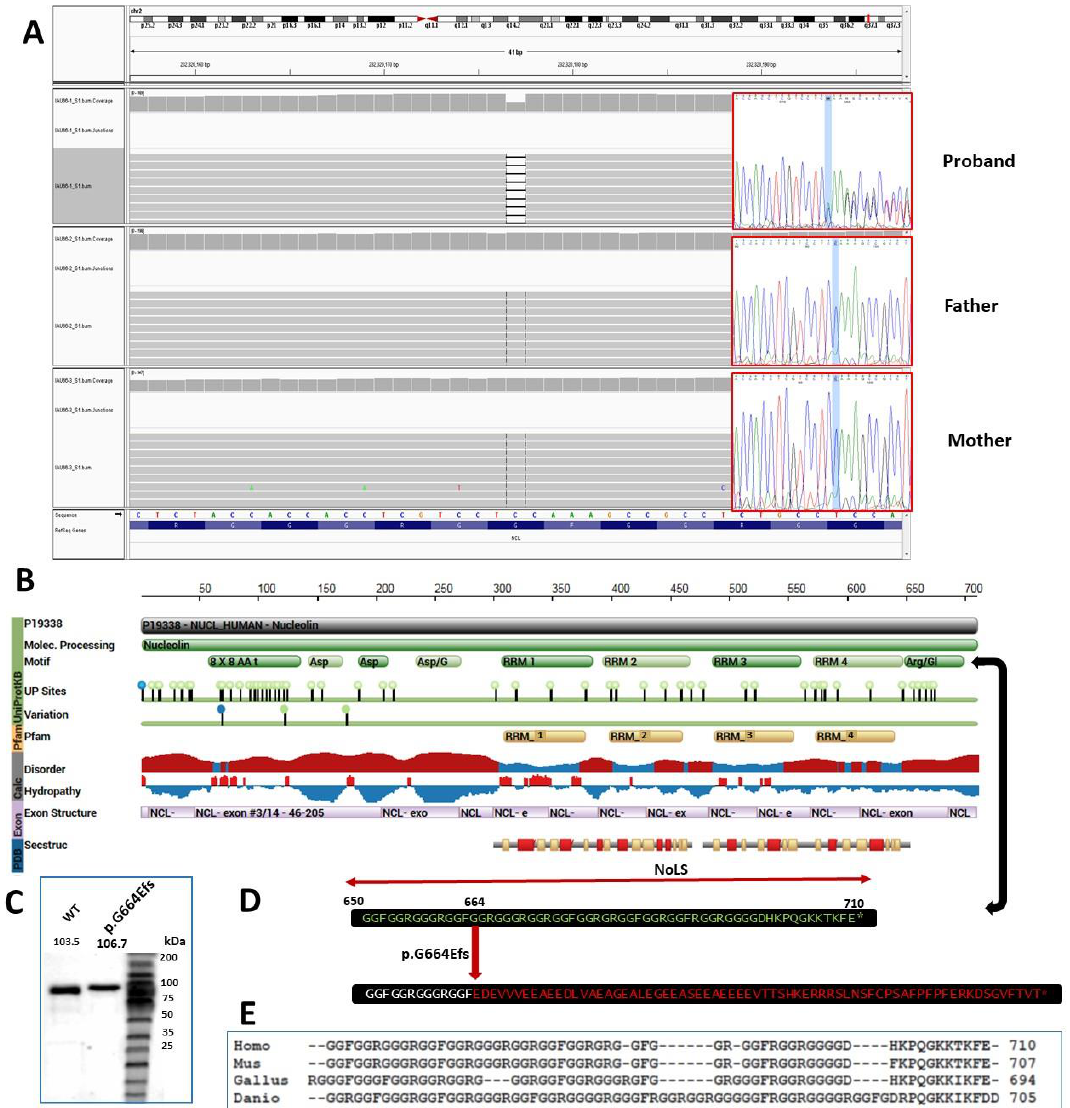
Figure 1. NCL mutation and protein structure. ( A ) Alignment of whole-exome sequence reads for proband, father and mother in Integrated Genomics Viewer (IGV: https://software.broadinsti- tute.org/software/igv/ (accessed October 2021)), and electropherograms for Sanger sequencing val- idation (through tcag.ca). ( B ) NCL protein feature view using Interpro (www.ebi.ac.uk/interpro (ac- cessed October 2021)) showing known and/or predicted domains, post-translational modifications, phosphorylation sites and disorder and hydropathic regions of NCL protein. ( C ) Western blot show- ing GFP fused full-length wild-type and p.G664Efs recombinant NCL protein. ( D ) C-terminal resi- dues of wild-type and p.G664Efs NCL protein and ( E ) The evolutionary conservation analysis of nucleolin